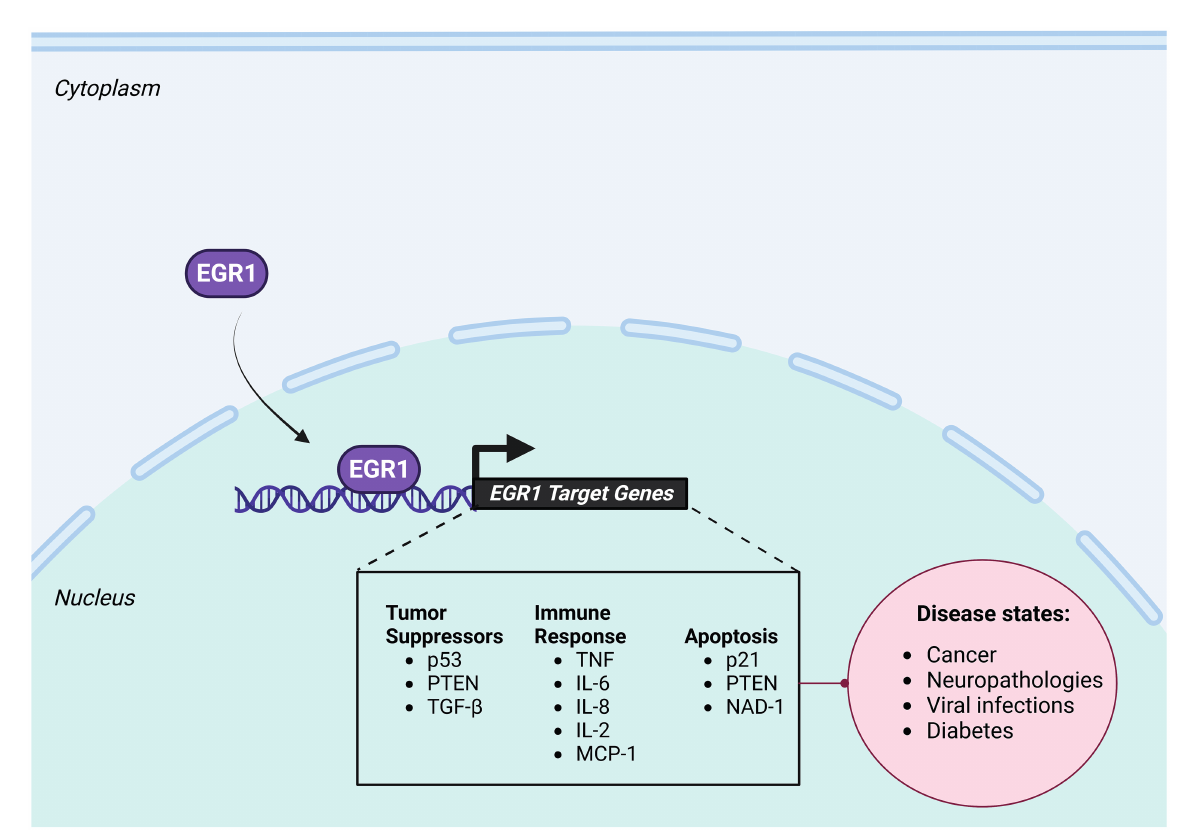
FIGURE 3 Downstream Targets of EGR1. EGR1 induces transcription of a large repertoire of genes, including tumor suppressors, immune response genes, and apoptotic factors. Changes in EGR1 dependent gene expression have been correlated with multiple disease states including cancer, diabetes, neuropathologies, and viral infections. Created with